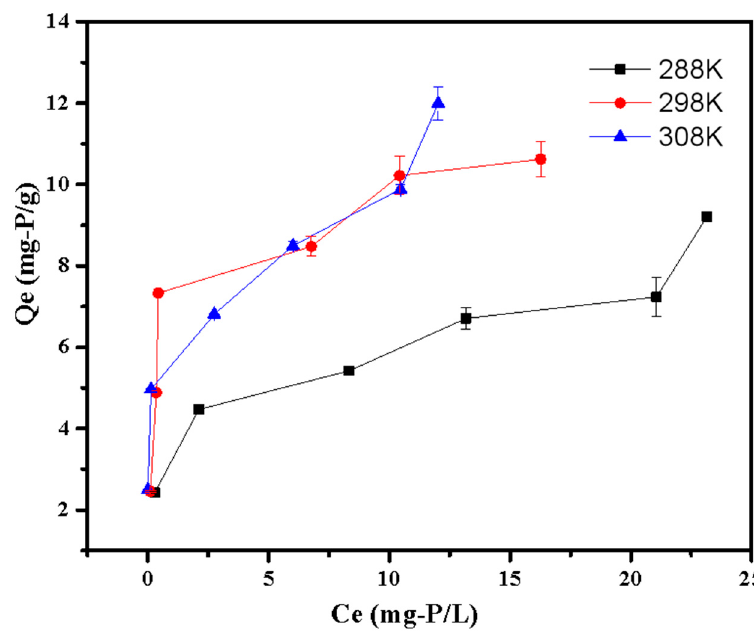
Figure 10. Adsorption thermodynamic of phosphate adsorption. Table 5. Thermodynamic constants of phosphate adsorption.